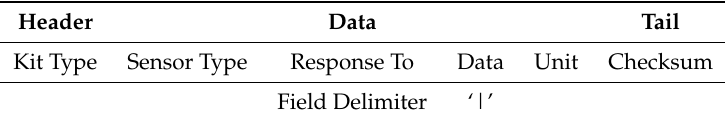
Table 3. Sensor data and response